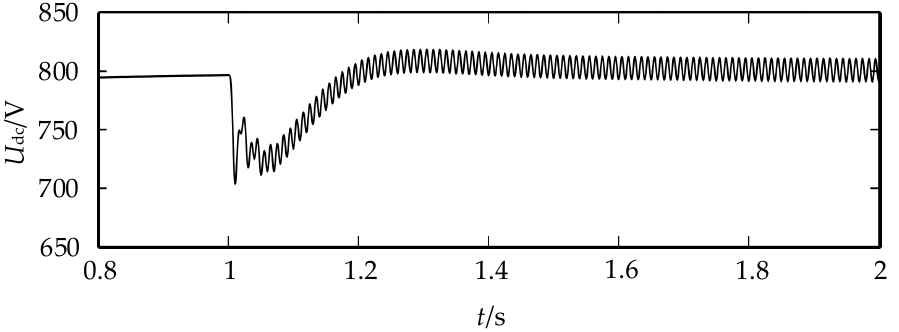
Figure 10. Three ‐ phase currents with a PI current inner loop.